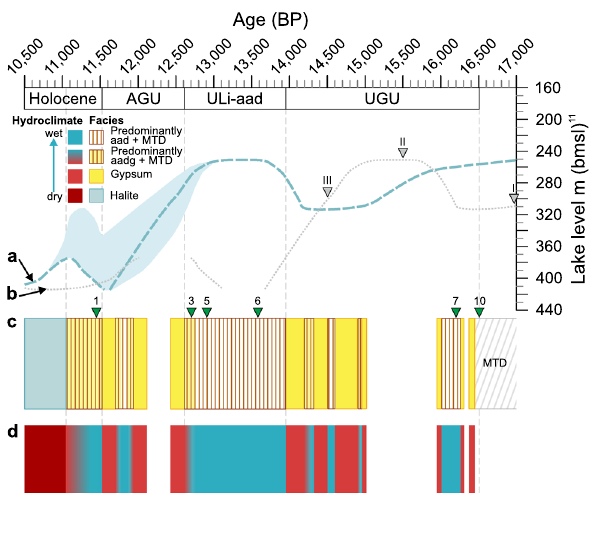
Figure 5. Thin section and XRF-mapping based microfacies changes and their hydroclimatic interpretation versus published lake-level curve. ( b ) Lake level curve (in m below mean sea level, m bmsl) from Torfstein et al. (2013) 11 ( a ) on the updated chronology. Note that the exact timing of the lake level drop during the AGU is uncertain as displayed by the light-blue shaded background. ( b ) Tuned U/Th ages from Masada 10 are shown by grey triangles. ( c ) Microfacies variations shown on the updated chronology. Position of age tie points from the updated chronology (Fig. 2, “Methods”) are shown by green triangles. Numbering of ages according to Fig. 2 and Table S1. Ages 1, 7 and 10 denote radiocarbon ages from Kitagawa et al. 23 , and ages 3, 5 and 6 indicate the position of tephra horizons from the Nemrut V-16 and Süphan swarm eruptions V8-V15 from Neugebauer et al. 22 . Tephra ages are from Landmann et al. 30 and Schmincke & Sumita 29 . Yellow rectangles: gypsum beds; brown-white streaked rectangles: predominantly aad varves including intercalated MTDs; brown-yellow streaked rectangles: predominantly aadg varves including intercalated MTDs; gaps in the facies mark core gaps. ( d ) Hydroclimatic interpretation of the microfacies in ( c ). Gypsum indicates pronounced drops in lake level during negative water budgets (dry phases: red boxes) and aragonite varves indicate rising lake levels during a positive water budget (wet phases: blue boxes). Dark red rectangle: driest phase with lake level drop below ~ 400 m bmsl leading to halite deposition. AGU additional gypsum unit, ULi-aad Upper Lisan aad, UGU Upper Gypsum